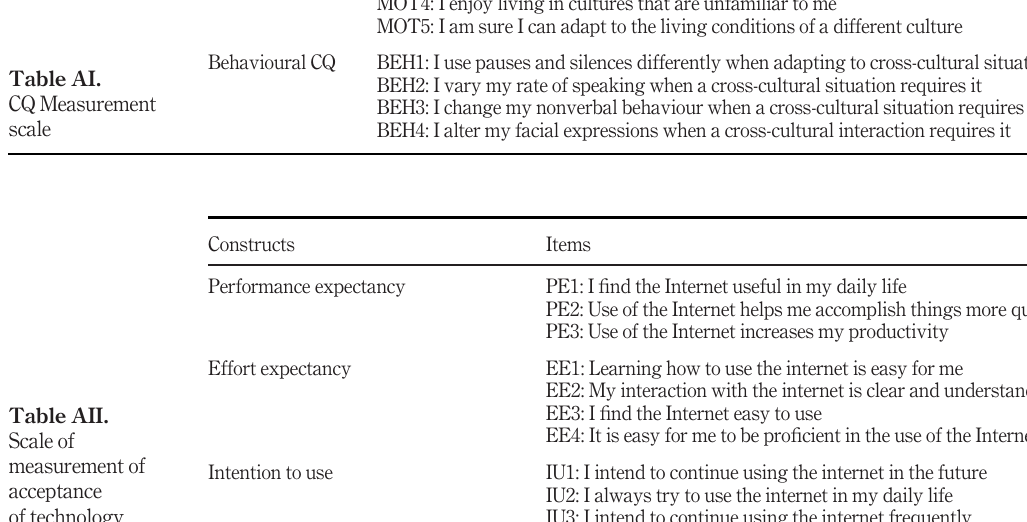
Table AII. Scale